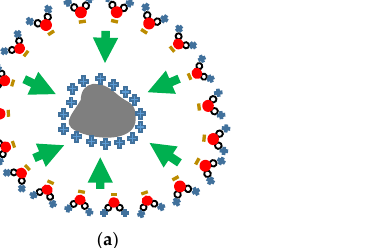
Figure 10. ( a ) Adsorption between water molecules and micro solid particles; ( b ) water film around micro solid particles.